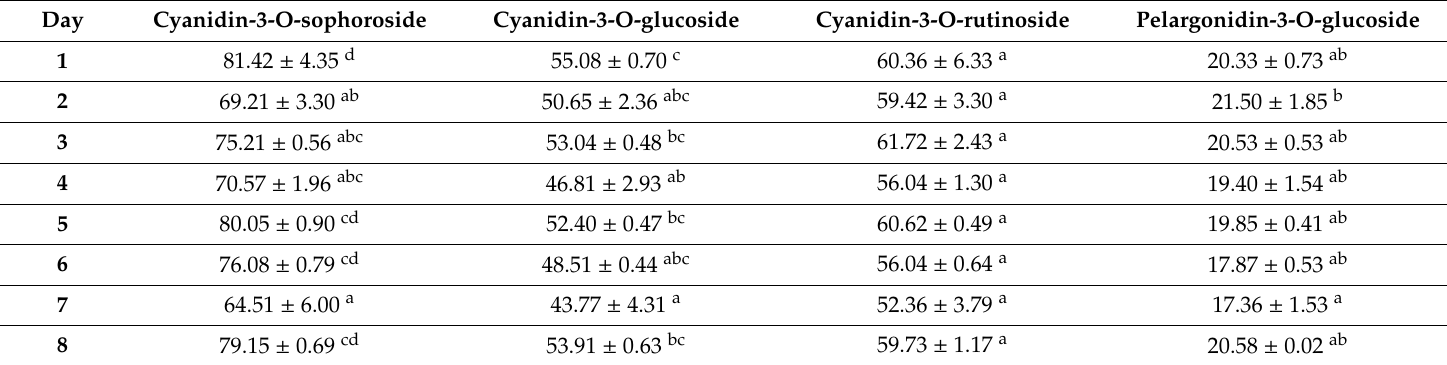
Table 15. Fruits stored at 1 ◦ C in fridge without packaging. E ff ect of storage period on the di ff erent anthocyanidin compounds content in red raspberries (cv. Erika). Results are expressed in µ g / g of fresh weight. The results are the mean of three replicates ± Standard Deviation. n.s. (not significant). The letters represent the significant di ff erence vertically at P ≤